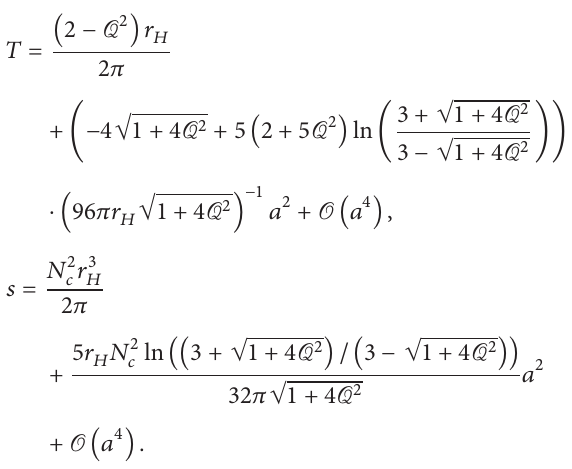
= 9 (red dotted) for 𝑎 2 = 0.01 𝑥